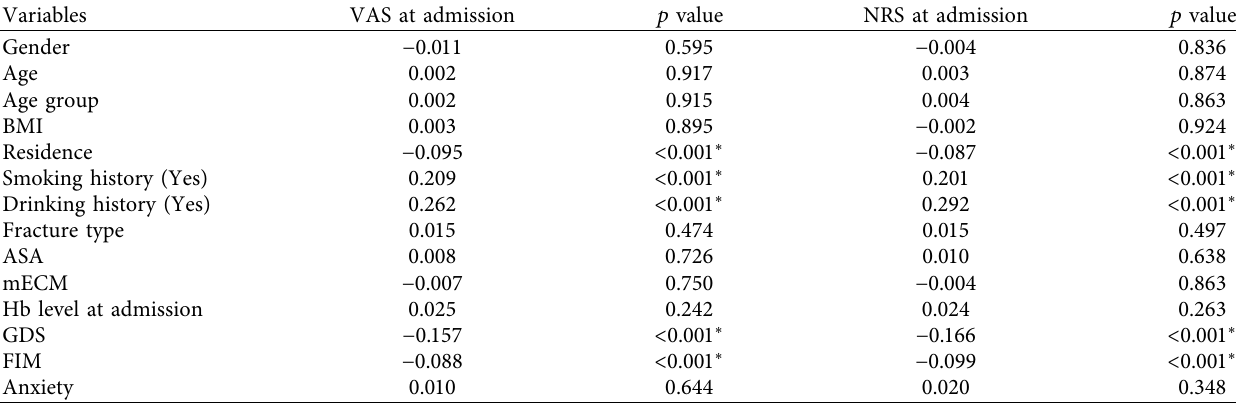
Table 4: The association of pain scores (VAS and NRS) with gender, age, BMI, residence, smoking or drinking history, fracture type, ASA, mECM, Hb level at admission, GDS, FIM, and anxiety.